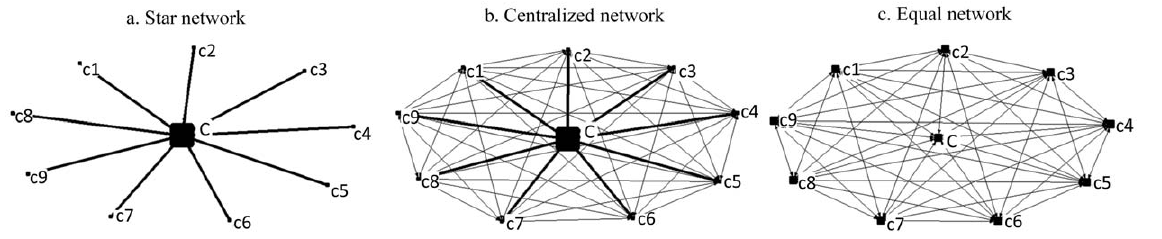
Figure 1. Graph representation of social networks. (a) Star network (extremely centralized), (b) centralized networks (highly, intermediately, and low), and (c) equal network (extremely decentralized). Squares represent individuals. C is the central individual, c 1–9 are non central individuals. Lines are relationships between individuals: the thicker the line, the stronger the relationship. The size of square represents the eigenvector centrality: the bigger the square, the higher the centrality.